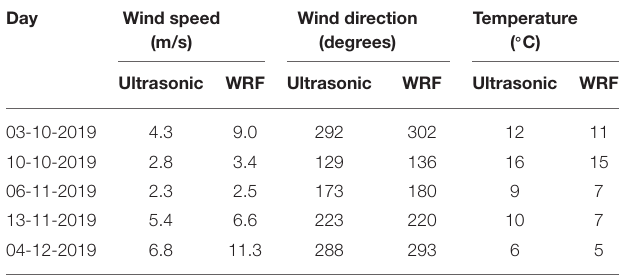
TABLE 1 | Wind speed (m/s), wind direction (degrees) and temperature ( ◦ C) as calculated from the ultrasonic (4.1m) and from the weather model (WRF, 10 m). Day Wind speed Wind direction Temperature (m/s) (degrees) ( ◦